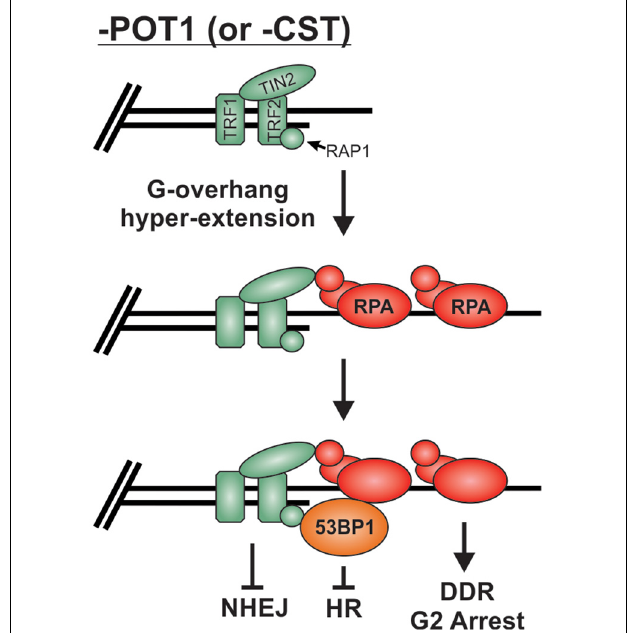
FIGURE 9 | Potential mechanism for the protection of RPA-bound telomeres. Loss of POT1 or CST results in hyperextension of G-overhangs and telomeric RPA but very few fusions events. We propose that the combination of TRF2 and 53BP1 prevent fusions by blocking NHEJ and HR mediated repair,